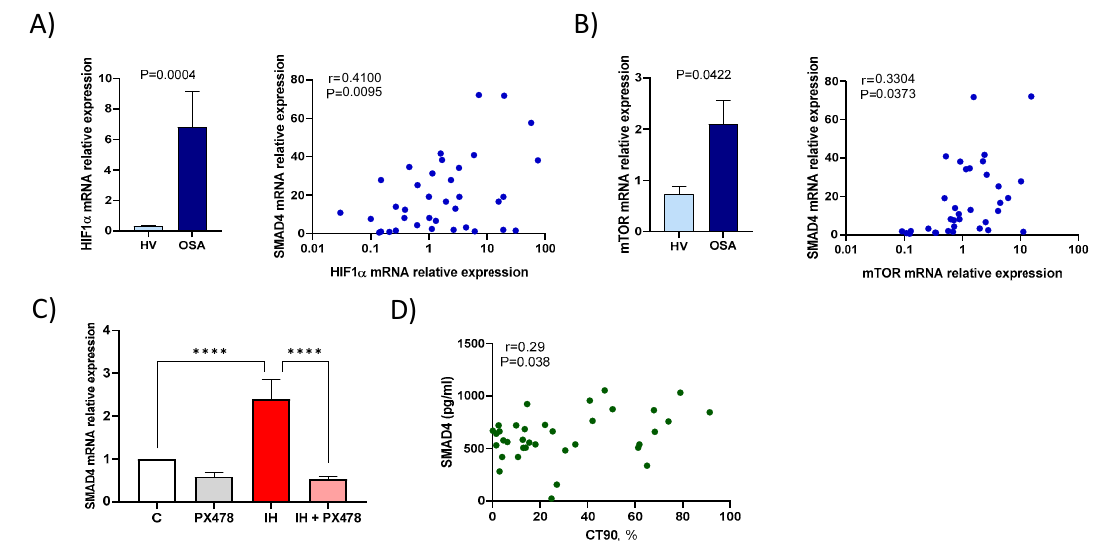
Figure 2. Hypoxaemia is related to SMAD4 expression in OSA patients. Relative expression of mRNA in monocytes from OSA patients (OSA) ( n = 40) and healthy volunteers (HV) ( n = 18). Correlation between relative expression of mRNA of HIF1 α ( A ) or mTOR ( B ) with that of SMAD4 in monocytes from OSA patients ( n = 40). OSA patients were randomly selected. Means ± SEM, Spearman’s correlation coe ffi cients (r) and p -values are shown ( C ) SMAD4 mRNA expression analysis by qPCR in monocytes from HV ( n = 7) treated with a specific inhibitor of HIF1 α (PX-478 15 µ M) and / or subjected to IH conditions for 16 h. Paired control samples were only incubated under normoxic conditions. Comparisons between groups were performed by two-way ANOVA. Means ± SEM are shown. **** p < 0.0001 cells are shown. ( D ) Relationship between nocturnal oxyhaemoglobin saturation lower than 90% (CT90) and plasma levels of Smad4 in OSA patients ( n = 35). Spearman’s correlation coe ffi cient and p -value are shown.